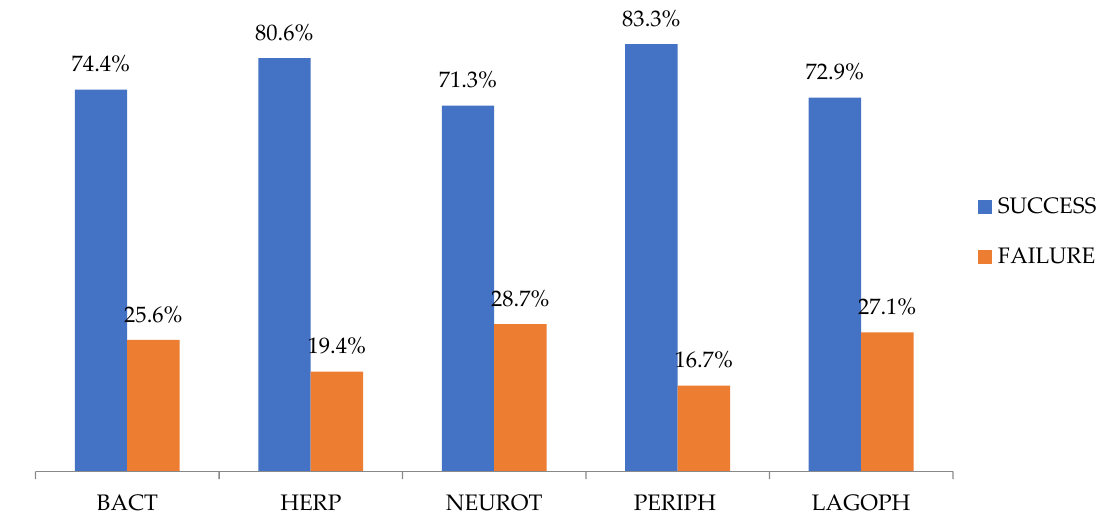
Figure 3. Amniotic membrane transplantation success and failure rates for each group of corneal ulcers. BACT, post- bacterial ulcers; HERP, post-herpetic ulcers; NEUROT, neurotrophic ulcers; PERIPH, non-rheumatic peripheral ulcers; LAGOPH, ulcers secondary to lagophthalmos and eyelid malposition or trauma.